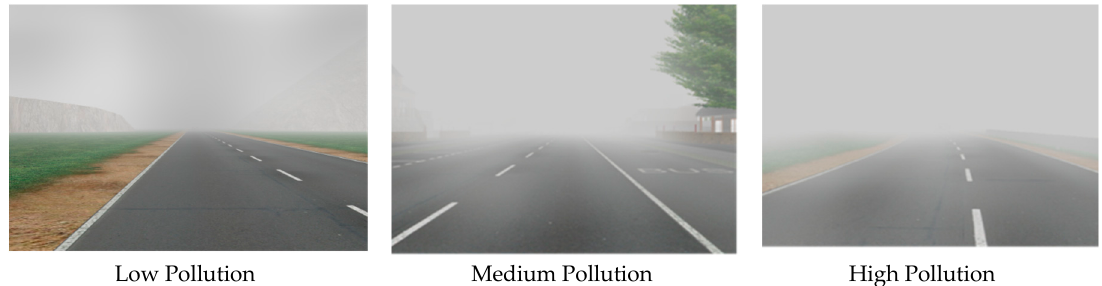
Figure 5. Synthetic Air Pollution images with low, medium and high levels.